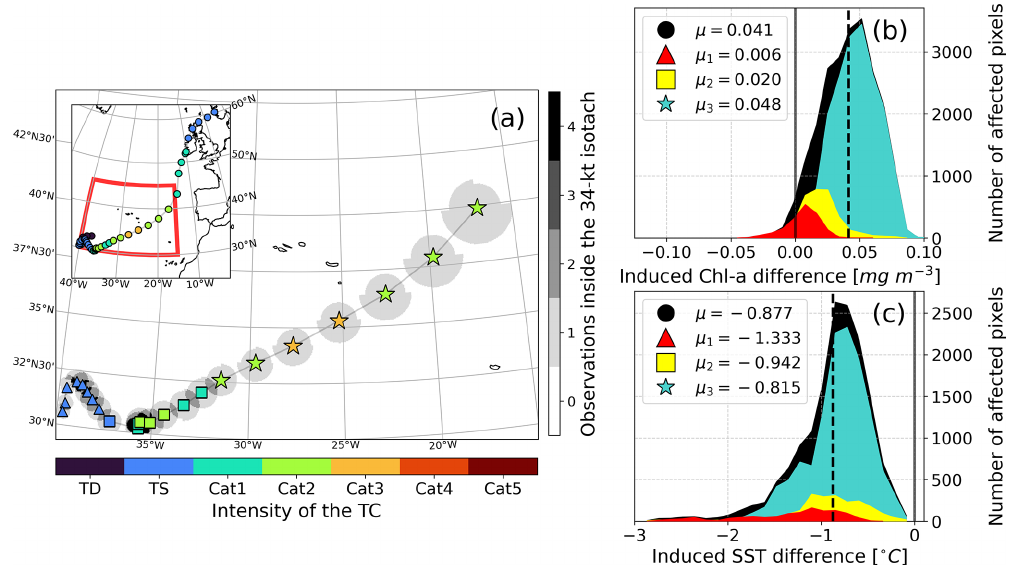
Figure 6. Case study for Hurricane Ophelia, in 2017, with its track on (a) (scatter marker colour scheme represents intensity as in Fig. 1), as well as the affected area around the cyclone (marked as the 34kt isotach) with shading according to the number of pixels overlapping. There is an inset with the full track and the region of study marked with a red box. Ophelia’s track is divided into three phases: histograms show induced Chl a (b) and SST induced anomalies (c) by phase of the storm (colours) and in total (black). The phase of the storm is marked in (a) as triangles (genesis), squares (maturing), and stars (mature) and correspond to the colours in (b) and (c)